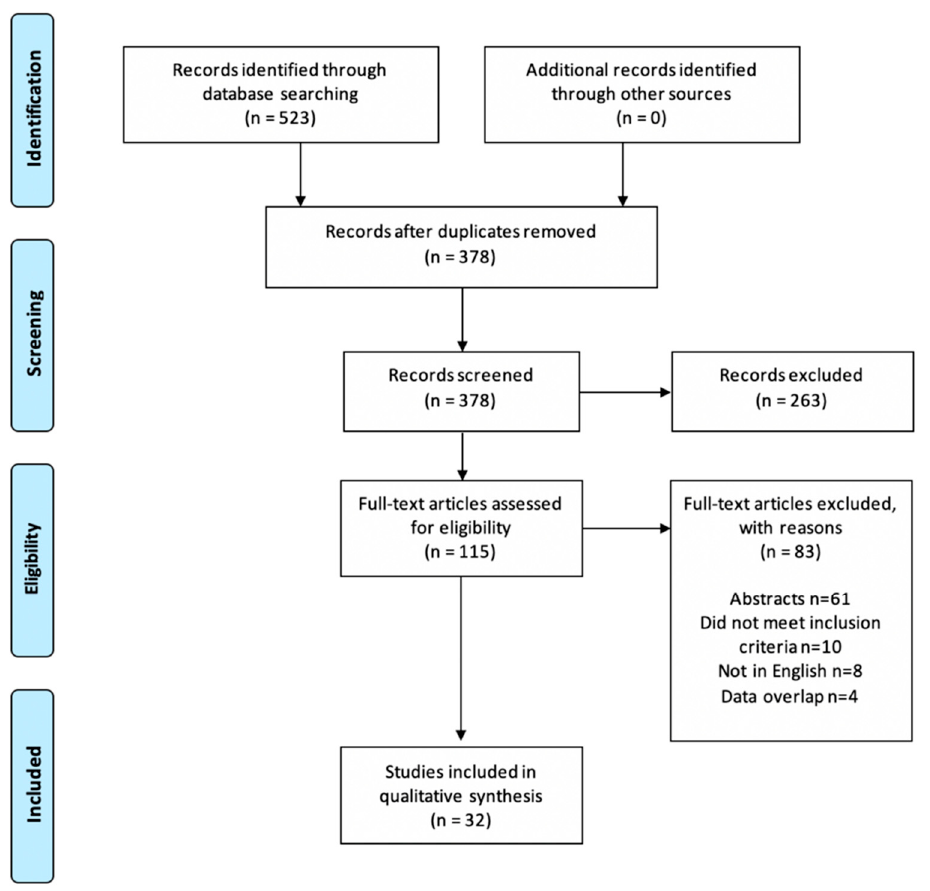
Figure 1. PRISMA flow diagram.